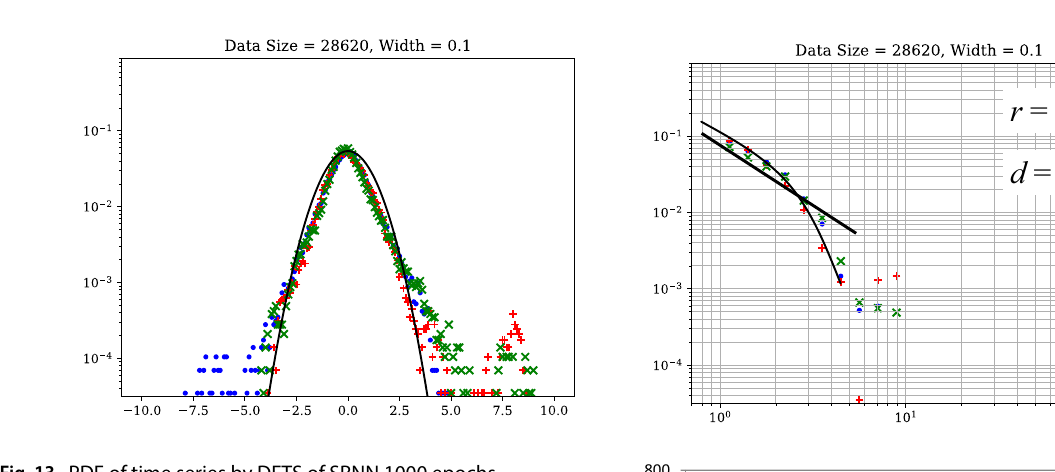
Fig. 13 PDF of time series by DFTS of SRNN 1000 epochs